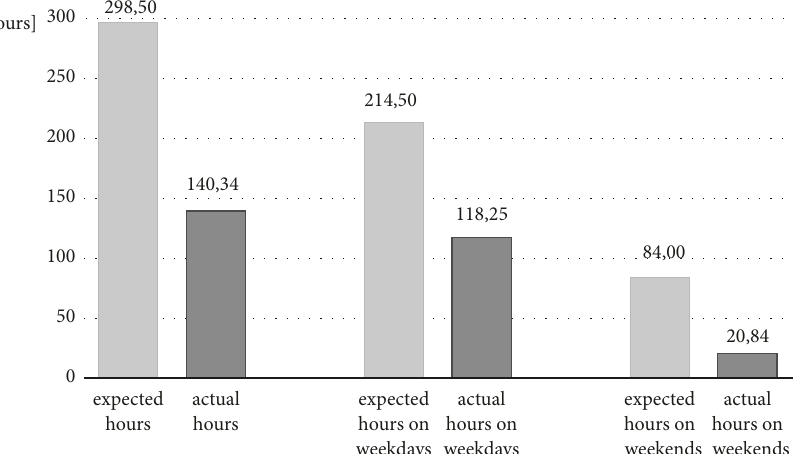
Figures 7 and 8 show the difference between the expected hours of use and the hours when the orthoses were actually worn for the DAFOs and the